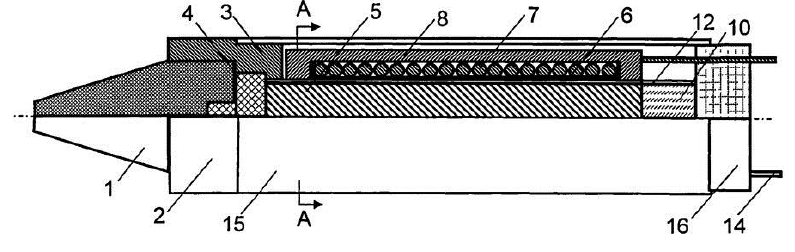
Fig. 3. Reflective PAA element draft.